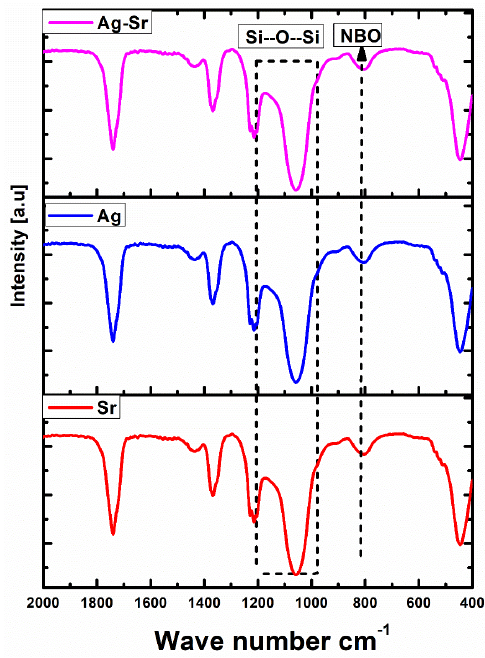
Figure 3. Energy dispersive X-ray (EDX) analysis of the synthesized particles: ( A ) Ag-Sr MBGNs and ( B ) MBGNs. The molecular structure of as-synthesized Ag-Sr MBGNs and the effect of doping on a network of glass were studied by FTIR spectroscopy, as shown in Figure 4. The re- sults depicted that no major difference occurs upon doping metallic precursors [30]. The bands around 455 and 1067 cm − 1 can be assigned to Si–O–Si rocking and Si–O–Si stretch- ing modes, respectively [31]. The broad band at 1200 to 1000 cm − 1 depicts Si–O–Si vibra- tions [32]. The peak around 800 cm − 1 is assigned to the Si–O–Si bridging bonds in the SiO 4 tetrahedrons [33].